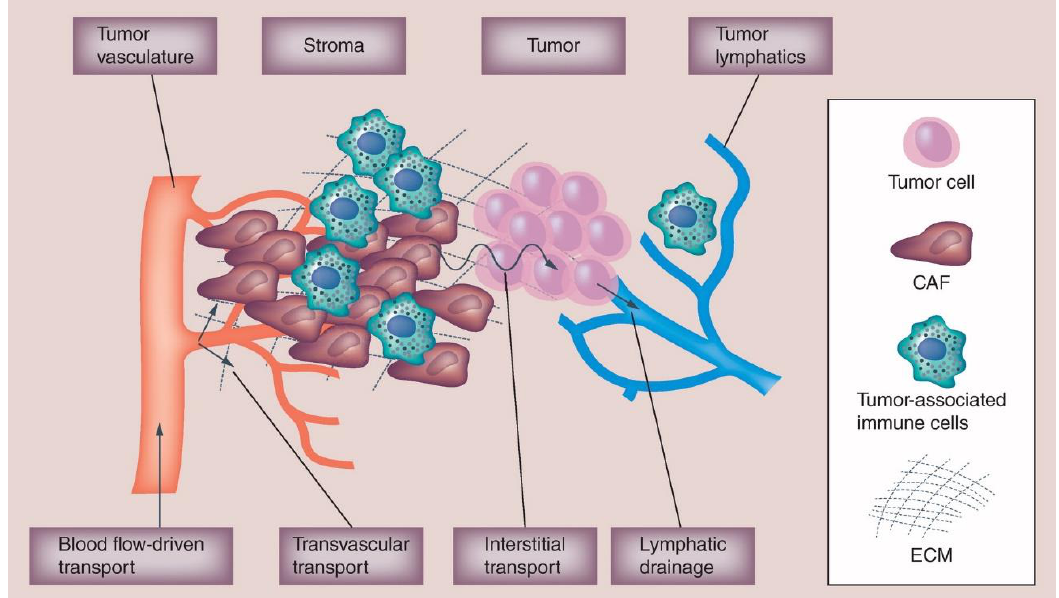
Figure 2. Complexity of the tumor microenvironment. The tumor microenvironment includes extracellular matrix (ECM), which poses multi-faceted barriers to drugs’ transport. The dense tumor stromal tissue, which is composed of collagens, fibronectin and hyaluronan, an abundance of cancer-associated fibroblasts, and aberrant interactions between infiltrating tumor-associated immune cells, cancer cells, and cancer-associated fibroblasts (CAF). Reproduced with permission from Lucas et al. [23]. Copyright Future Medicine Ltd., 2017.